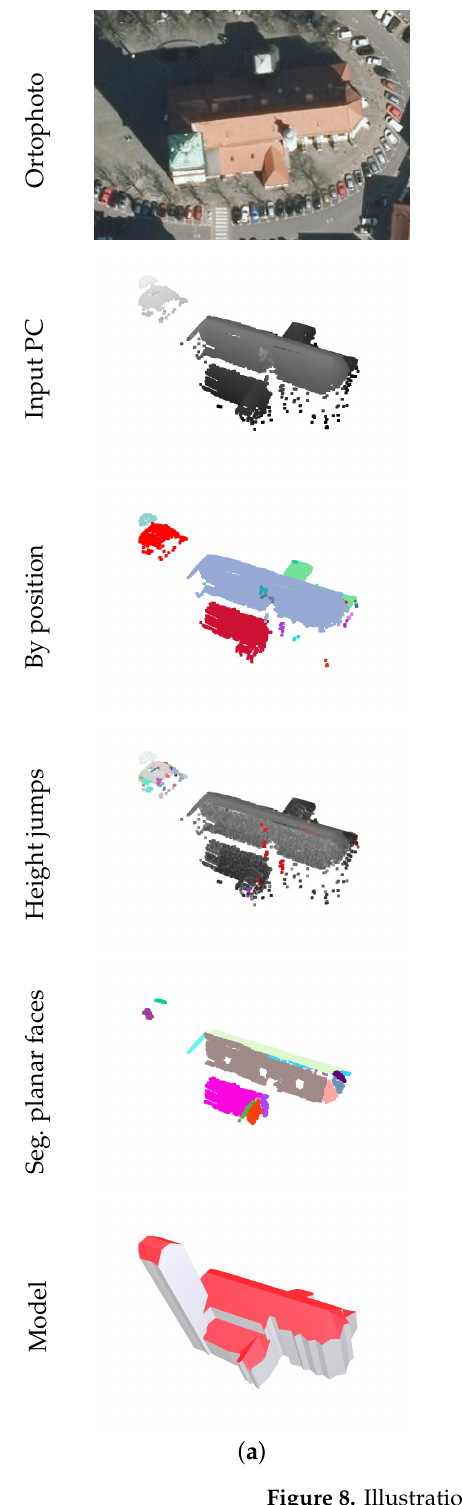
Figure 8. Illustrations of the reconstruction of buildings of various types, where for the buildings’ (top) input point cloud and subsequent intermediate results of the proposed methodology’s steps are shown for the reconstructed building models (bottom). ( a ) is a church with a multi-level roof, ( b ) is an example of high-rise buildings, and ( c ) is a complex building model with multiple height